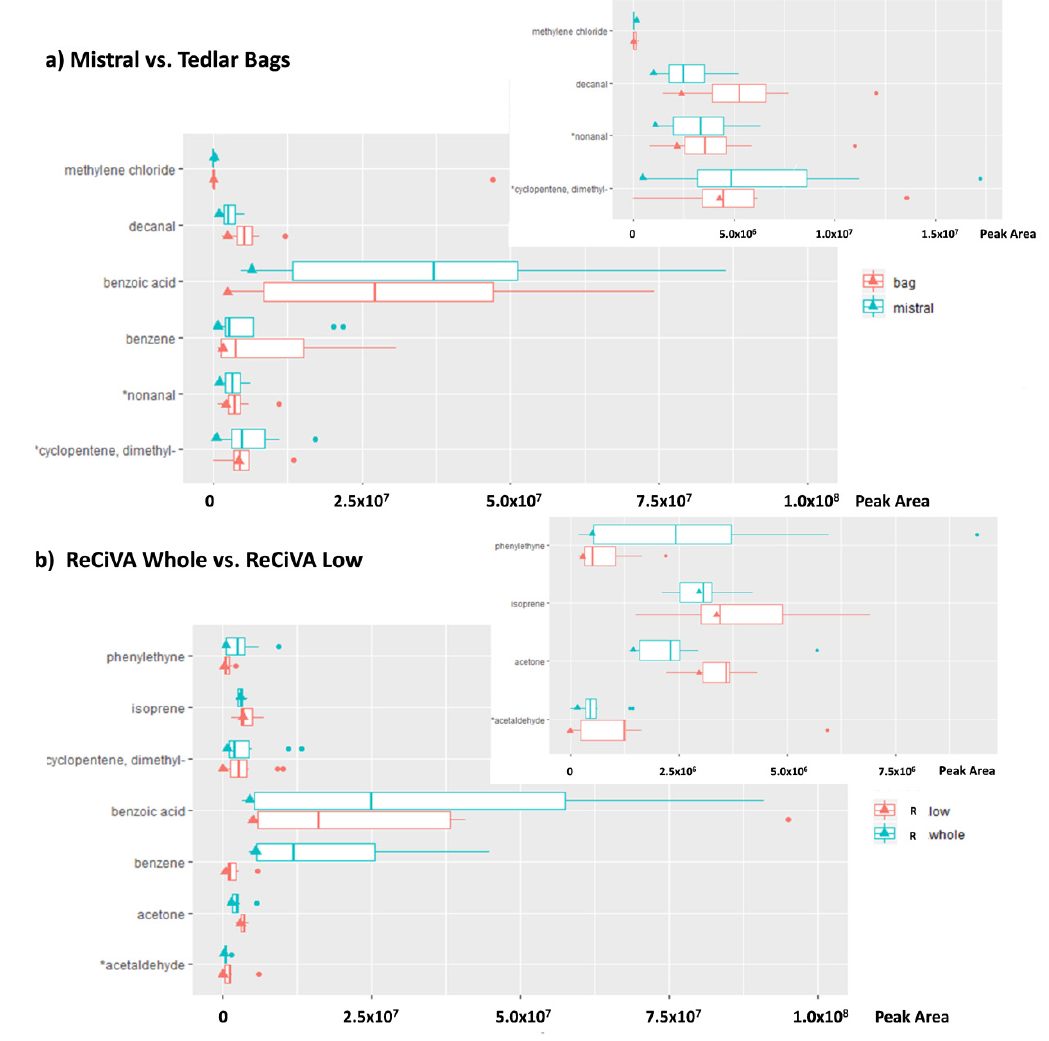
Figure 3. Peak area of volatile organic compounds (VOCs) significantly different at the 95% and (*) 90% of significance, respectively, in lower airways expiratory breath compared to whole expiratory breath. Comparison between Mistral and Bag ( a and insert) and between ReCIVA Whole and Low ( b and insert). Triangle represents the peak area value for the LC patient. A zoom of Figure 3a,b on a reduced scale of the x -axis is reported in the